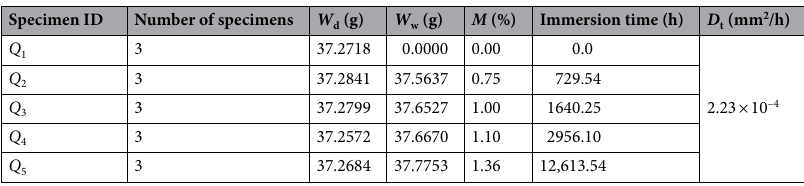
Table 1. Moisture absorption related parameters for quasi-isotropic composite